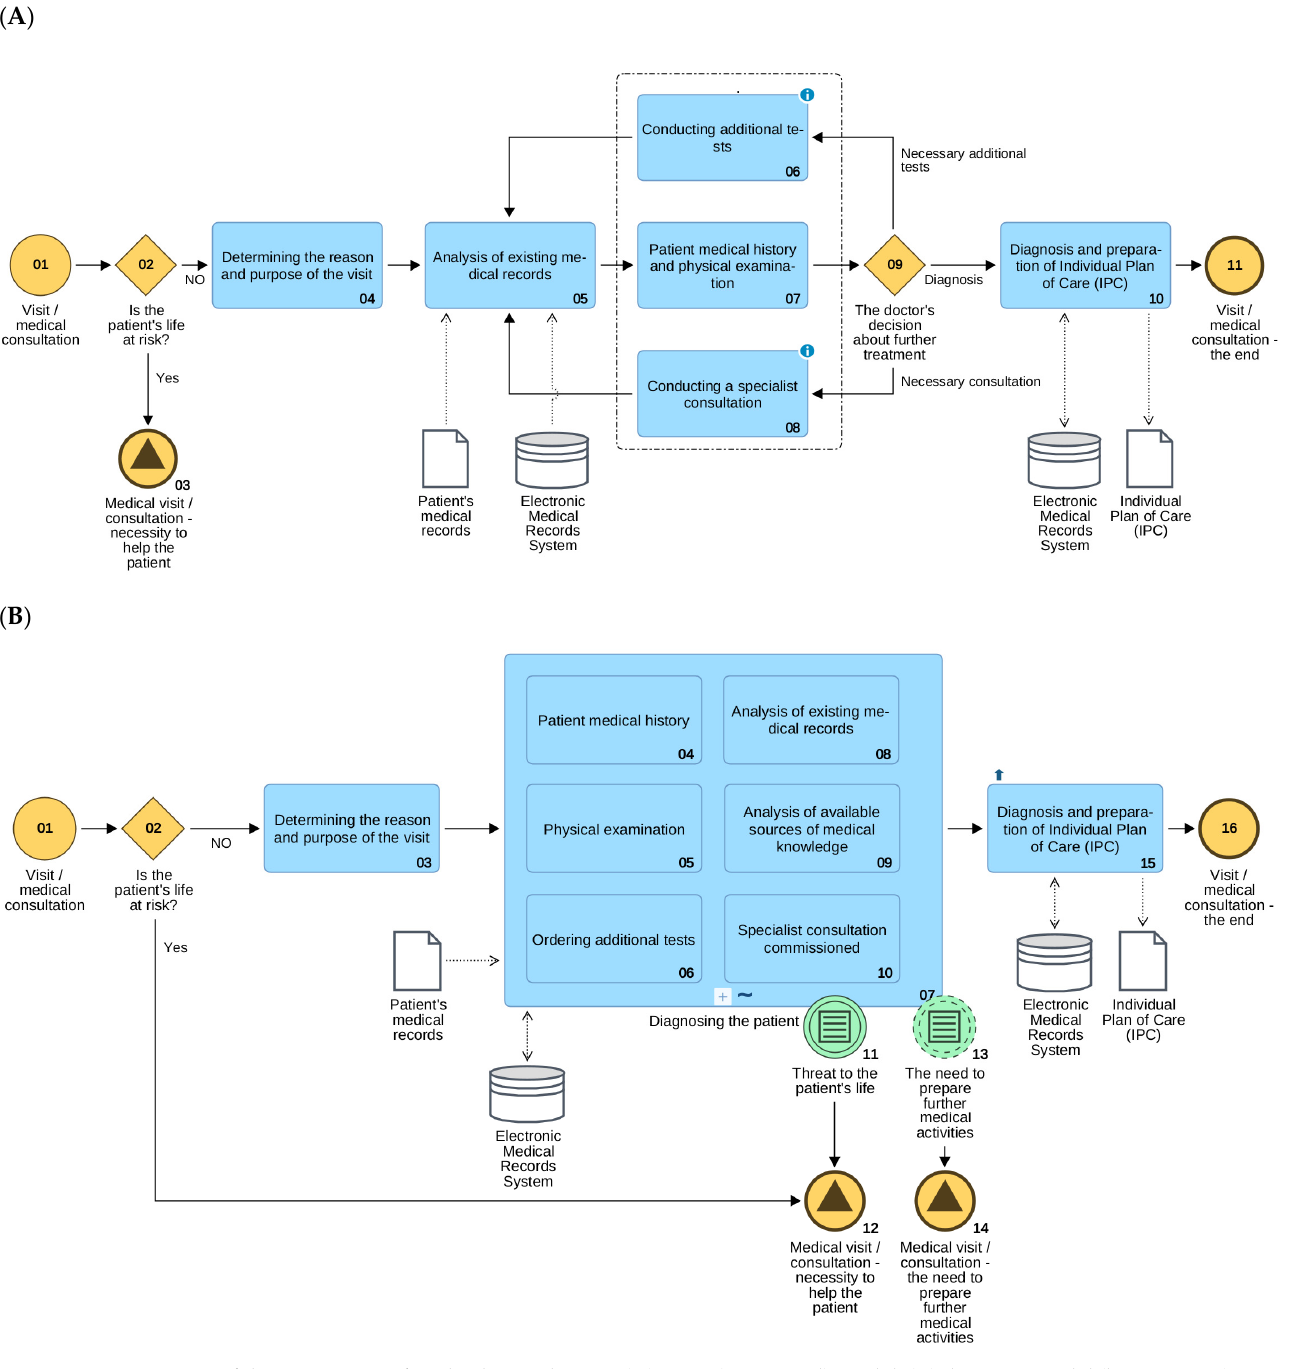
Figure 1. Diagram of the process visit/medical consultation: ( A ) static (structured) model; ( B ) dynamic model (by ADO- NIS).